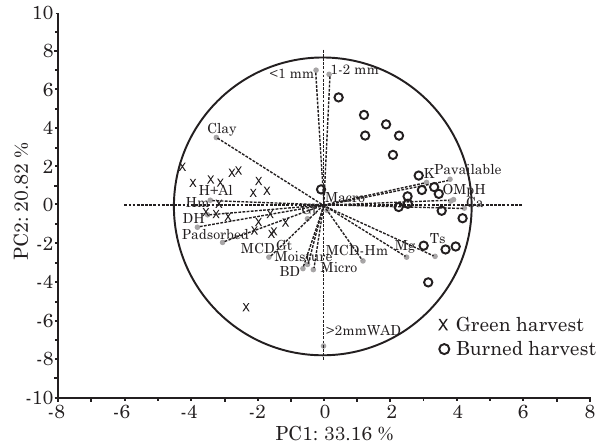
Figure 3. Scatter biplot of PC1 and PC2: clay content, total sand (TS), weighted average diameter (WAD), aggregates greater than 2 mm in size (> 2 mm), aggregates smaller than 1 mm (< 1 mm), aggregates 1-2 mm in size (1-2 mm), macropores (macro), micropores (micro), soil density (BD), moisture, Ca, Mg, K, H+Al, pH, P adsorbed, P available, degree of humification (DH), hematite content (Hm), goethite content (Gt), mean crystal diameter of hematite (MCD-Hm), and mean crystal diameter of goethite (MCD-Gt) in the 0.00-0.25 m soil layer. n = 40.